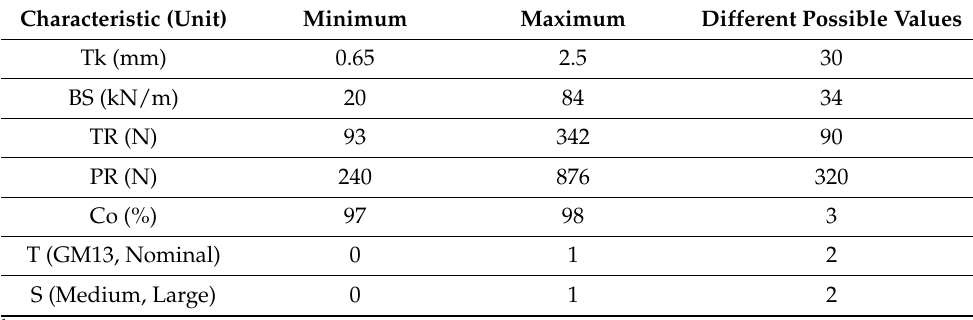
Table 2. Ranges 1 of each characteristic of the